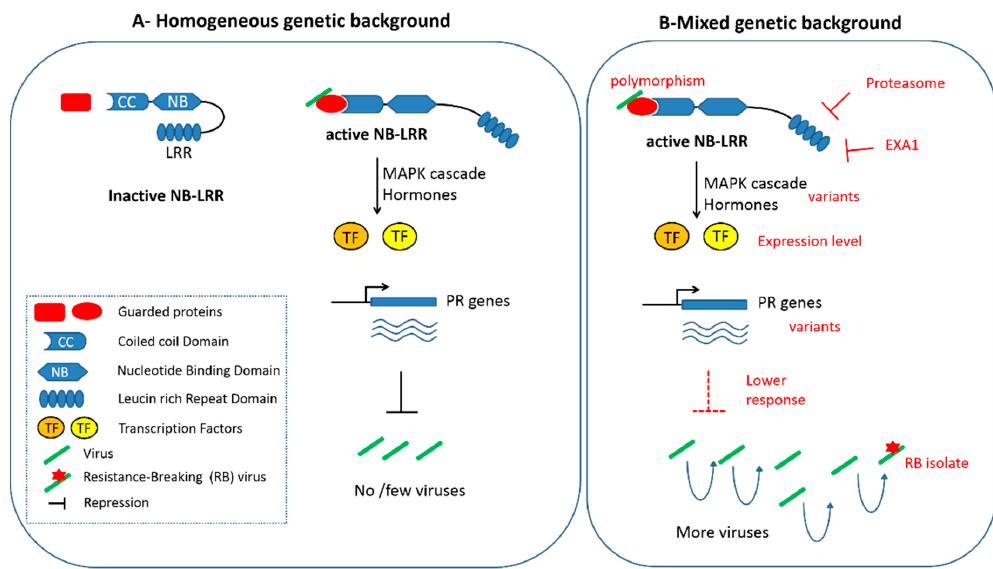
Figure 1. Potential effects of the genetic background on a NB-LRR based resistance to a viral pathogen. ( A ) classical representation of the guard model. On the left side, NB-LRR remains inactive in plants unchallenged by virus (represented by green rods). On the right side, virus-activation of NB-LRR resulting in a signaling cascade involving MAP Kinases and hormones, Transcription Factors (TF) activation of Pathogenesis-Related (PR) genes and ultimately, repression (or suppression) of the virus in the plant. ( B ) Potential regulations of the response cascade susceptible to act at each stage of the signaling response are indicated in red (see accompanying text for details). Those variations may decrease the efficiency of the response, therefore resulting in a higher accumulation of viruses in the plant, allowing the development of resistance breaking (RB) isolates, through mutations represented by a red